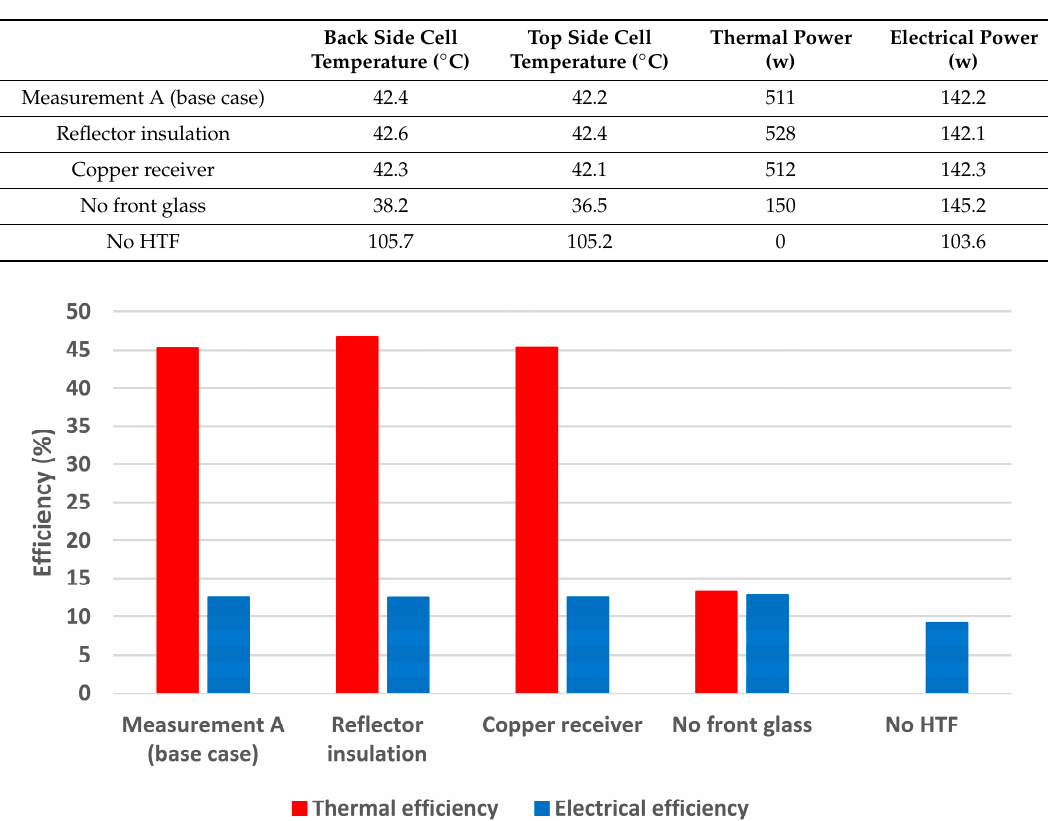
Figure 22. The thermal and electrical efficiency for collector’s modifications .